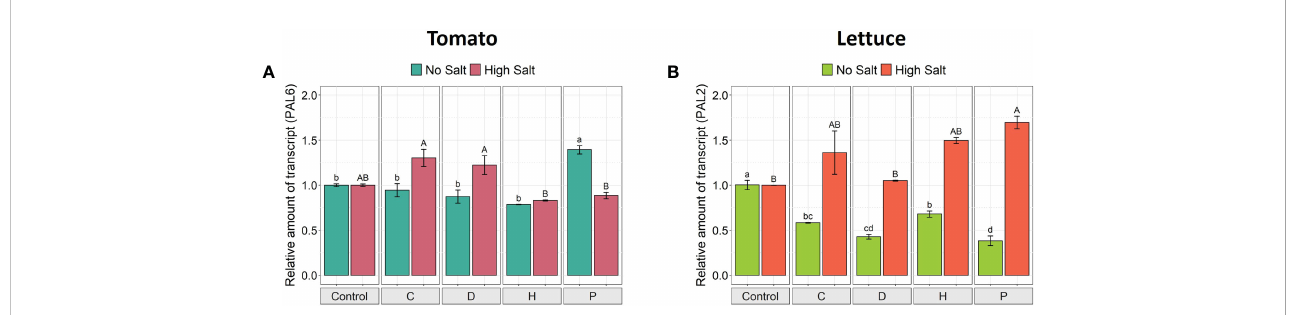
FIGURE 4 Gene expression analysis of PAL6 in leaves of tomato (A) and PAL2 in leaves of lettuce (B) grown under salinity stress and protein hydrolysates application. The expression levels of PAL6 and PAL2 genes were normalized to the expression levels of the elongation factor isoform 1-alpha (EF-1a) and the adenosine phosphoribosyl transferase (APT1), respectively. The relative expression ratios were calculated using the control treatment in each salinity condition as a calibrator sample. Values are means ± SE; n = 3. Lowercase letters compare treatments under no salt, and capital letters compare treatments under high salt. Equal letters correspond to average values that do not differ according to Tukey ’ s HSD test (p < 0.05).